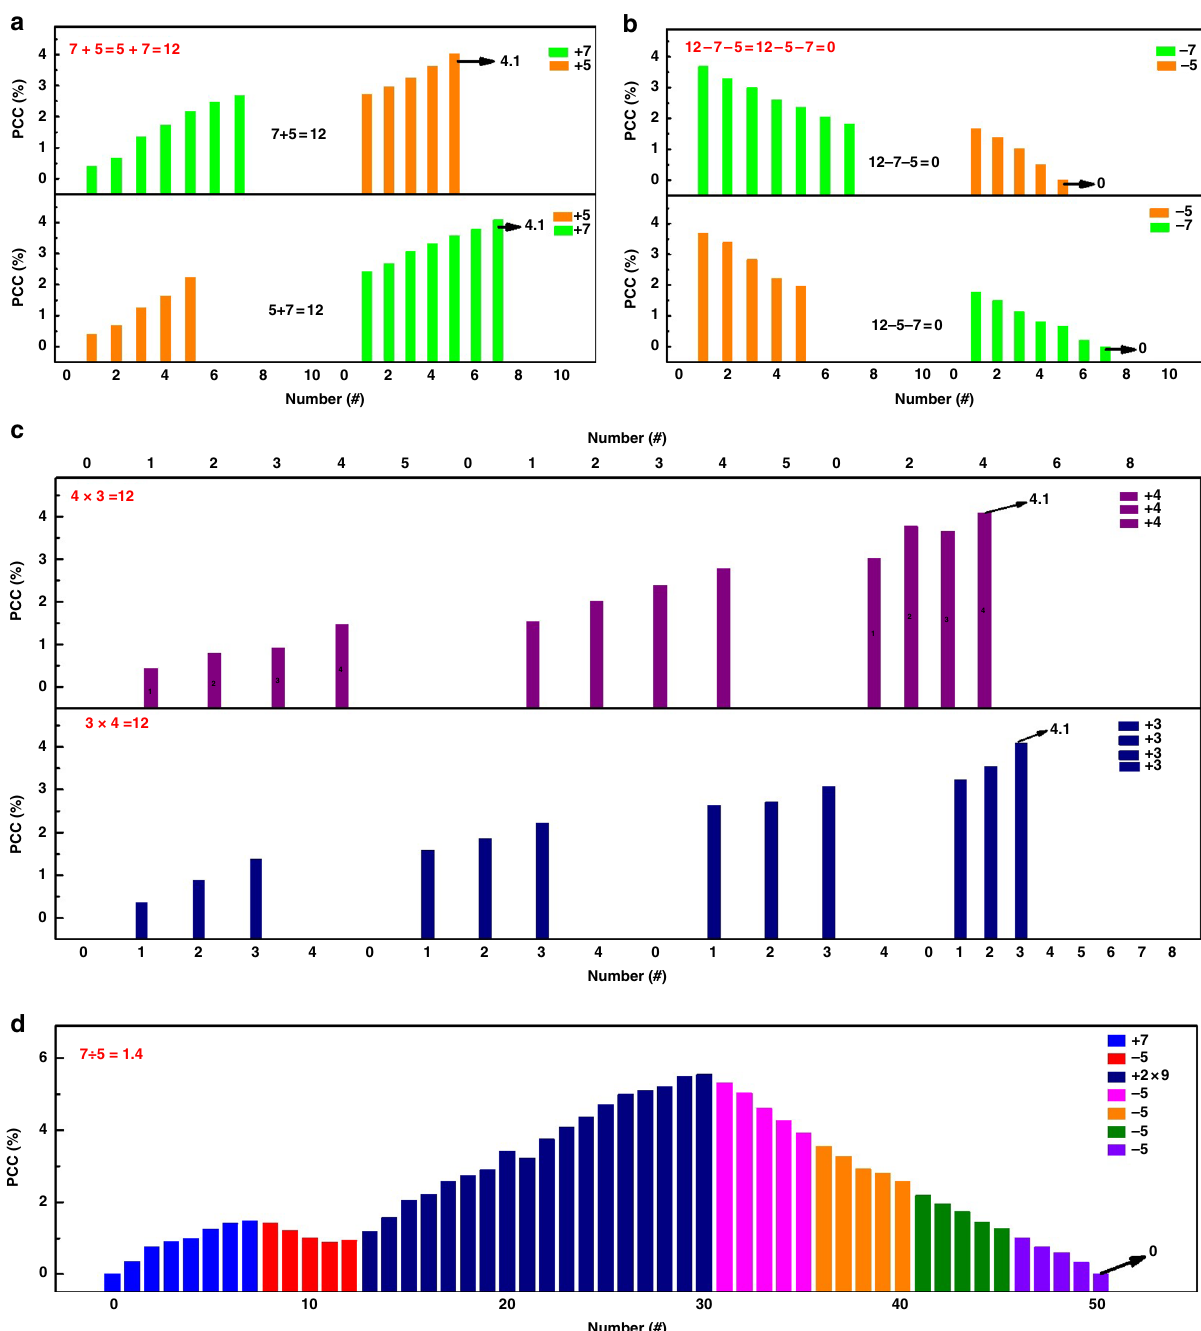
Fig. 6 Demonstration of arithmetic computing with the PFTPA-Fc memristor. a Commutative addition, b subtraction, and c multiplication, as well as d fractional division conducted with the ITO/PFTPA-Fc/Pt